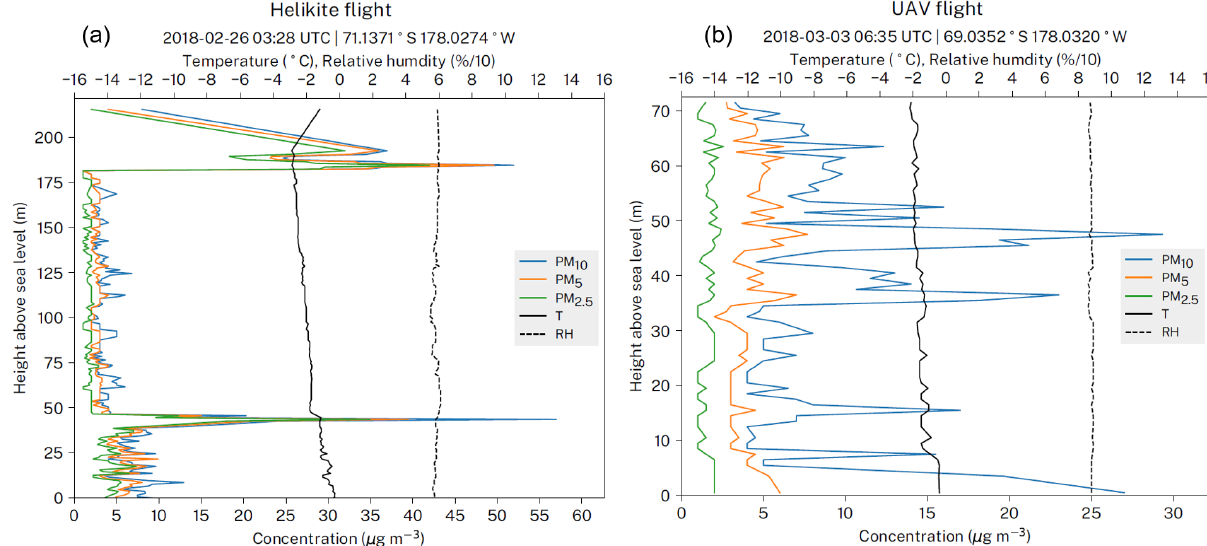
Figure 20. In situ boundary layer aerosol concentration, atmospheric temperature, and relative humidity in two locations in the Ross Sea sampled with (a) Helikite flight and (b) UAV flight. The sampling was performed using an Alphasense OPC-N2 unit connected to a ra- diosonde which were attached to the aircraft. Shown are the particulate matter (PM) concentrations (PM 2 . 5 , PM 5 , and PM 10 ), temperature ( T ), and relative humidity (RH). Height is based on the GPS coordinates of the radiosonde.